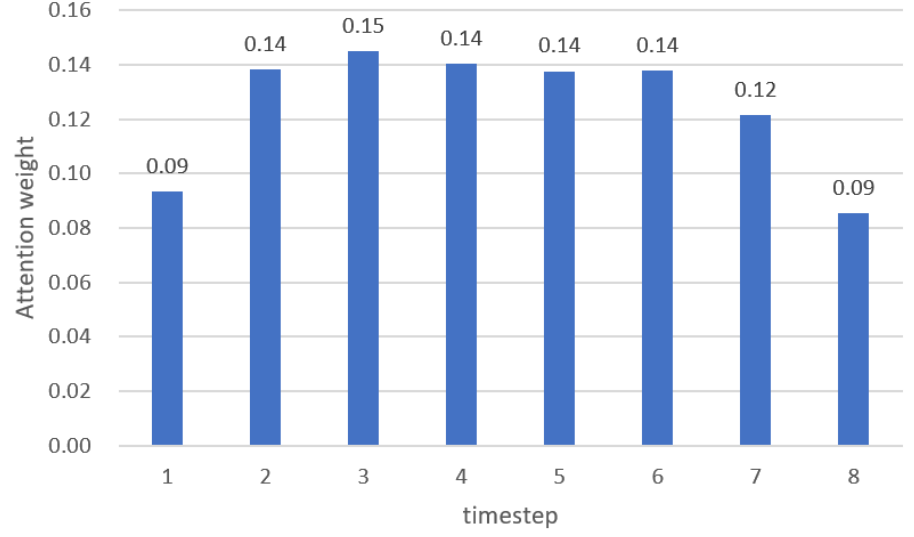
Figure 10. Mean attention weight across all datasets for each timestep.